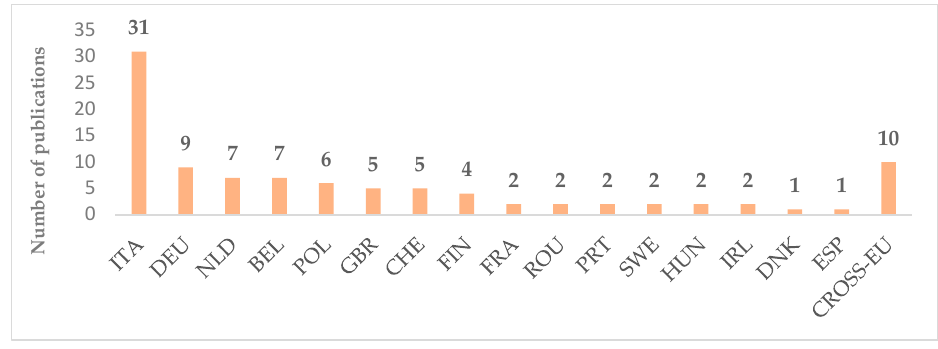
Figure 4. Geographical distributions of selected publications.